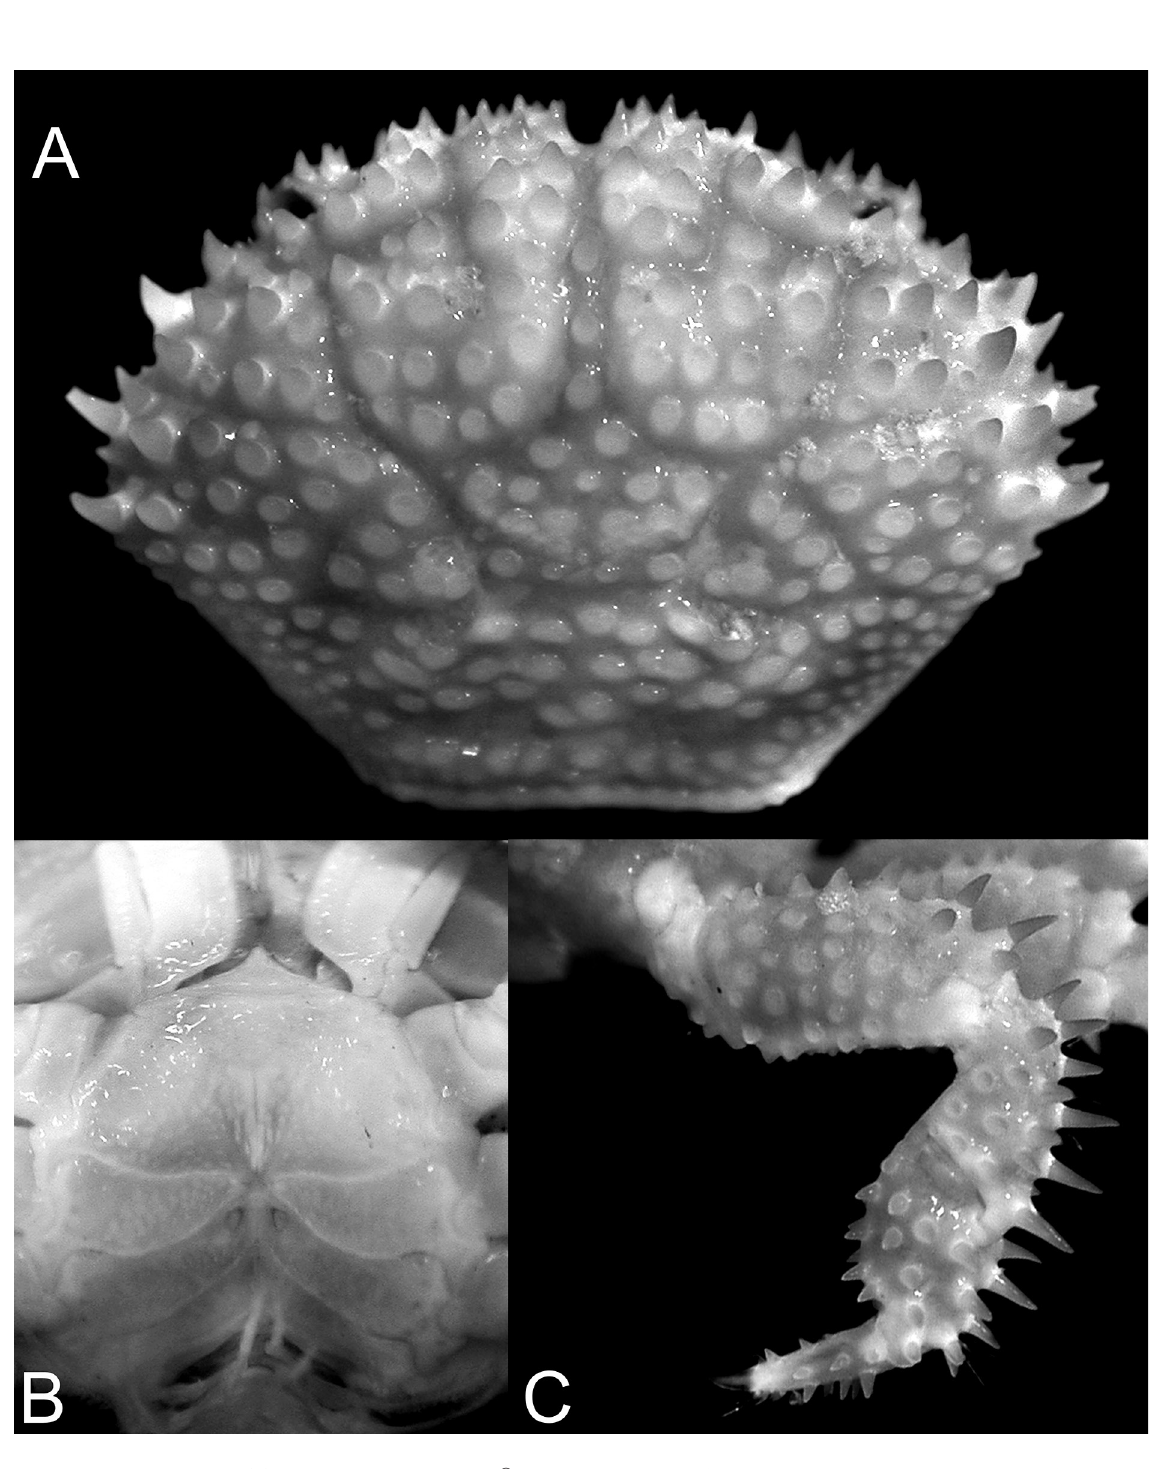
Fig. 4. Actaea grimaldii sp. nov., paratype, ♀, 10.2 × 7.8 mm (ZRC, ex MNHN IU 2013-1245), Papua New Guinea. A . Dorsal view of carapace. B . Thoracic sternum showing vulvae. C . Right fourth ambulatory